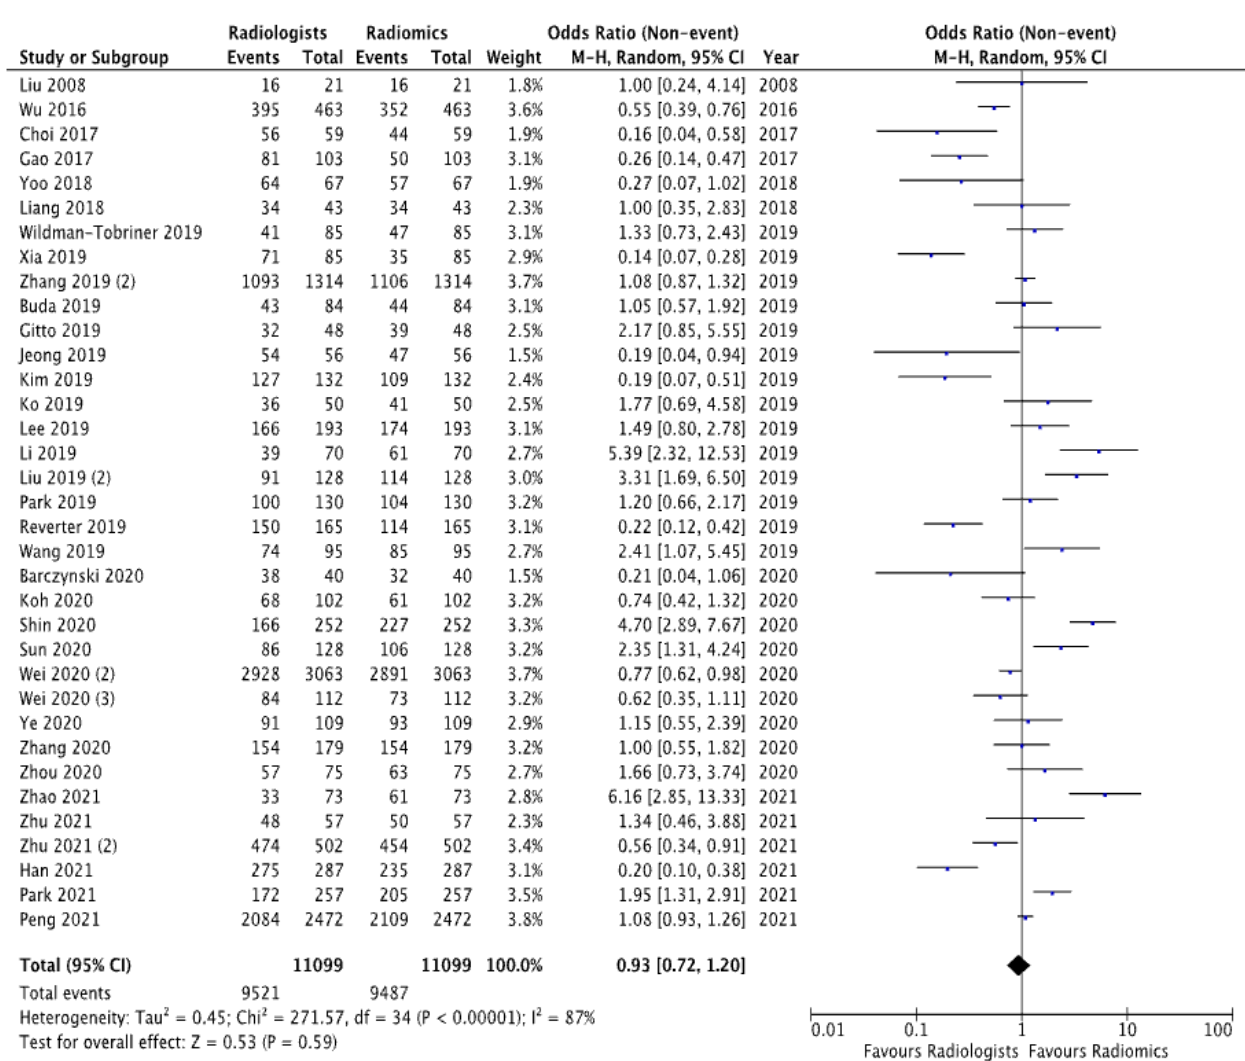
Figure 4. ( A ) Represents sensitivity comparison between radiologists and radiomics. ( B ) Represents specificity comparison between radiologists and radiomics.